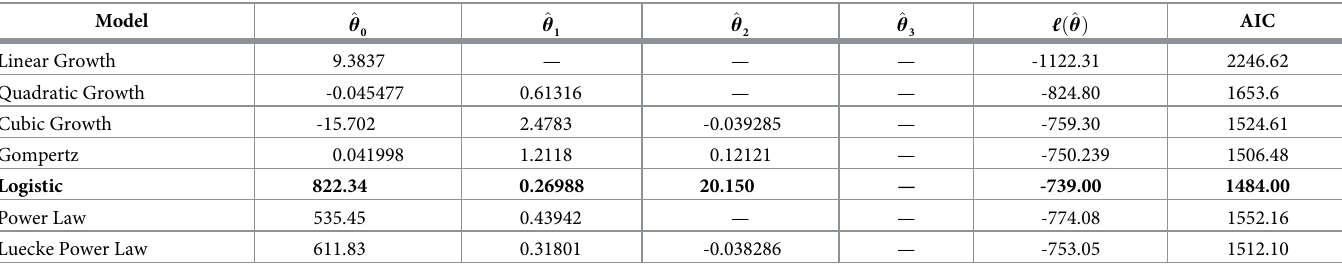
Table 12. Amniotic fluid volume models (volume in mL vs. fetal mass in kg for power law models, volume in mL vs. gestational age in weeks for all other models).